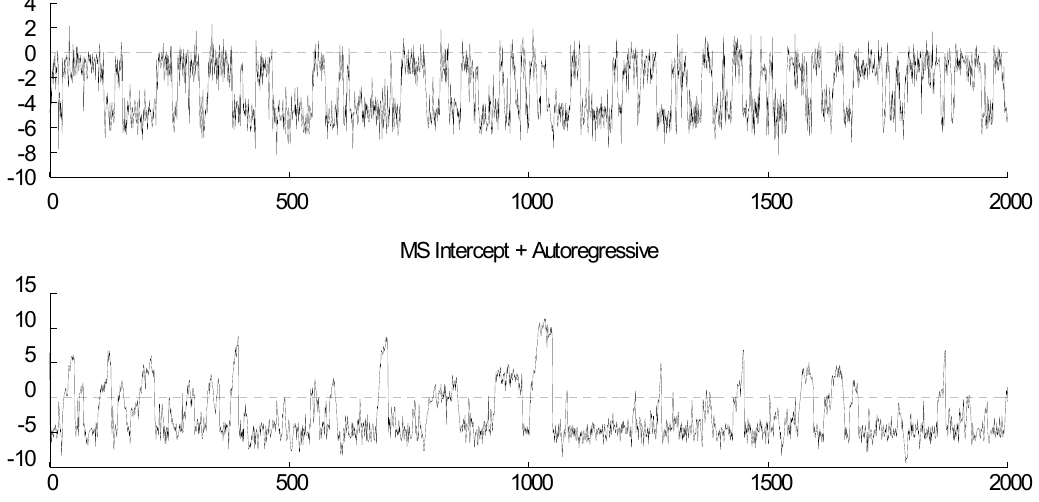
Figure 2. Plot of Simulated Series. The “MS Intercept” plot expresses Model 1, where the intercept switches between − 5 and 1, with p 11 and p 12 equal to 0.99. The “MS Intercept + Autoregressive” relates to Model 2, which assumes that the model switches from a unit root to a stationary process.